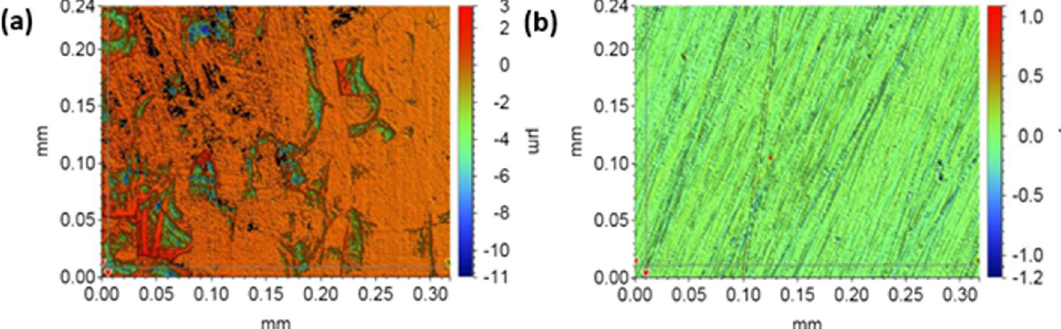
Fig. 4 Optical Pro fi lometry of ISG. a Localized attack on ISG( + SS) corroded in 0.6 M NaCl. b Optical Pro fi lometry of pristine